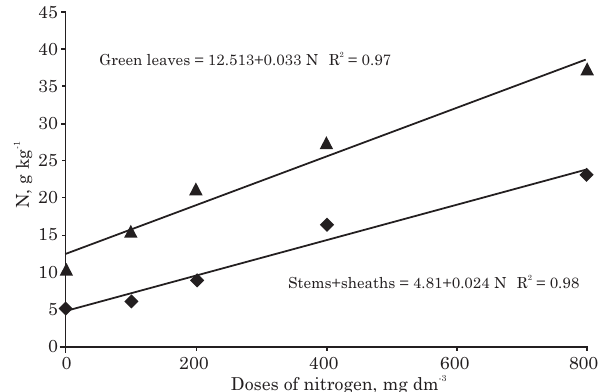
with standard deviation of variables that were